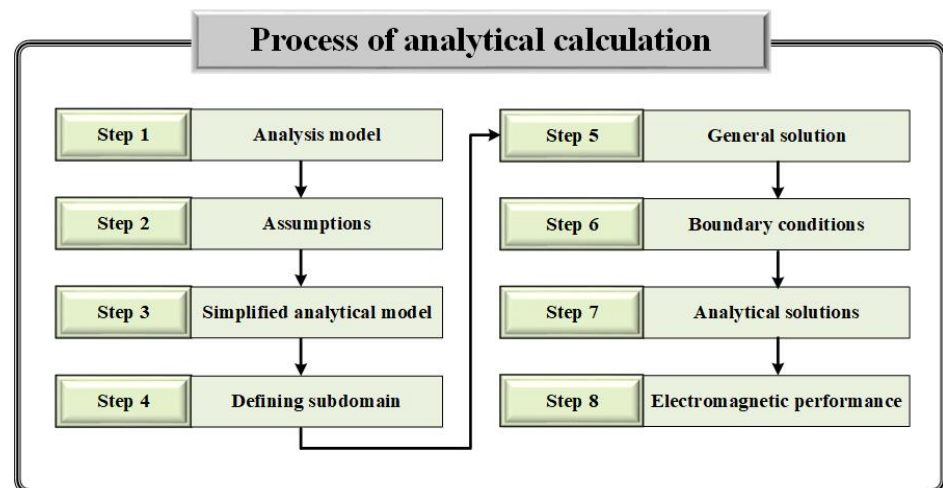
Figure 3. Process of analytical